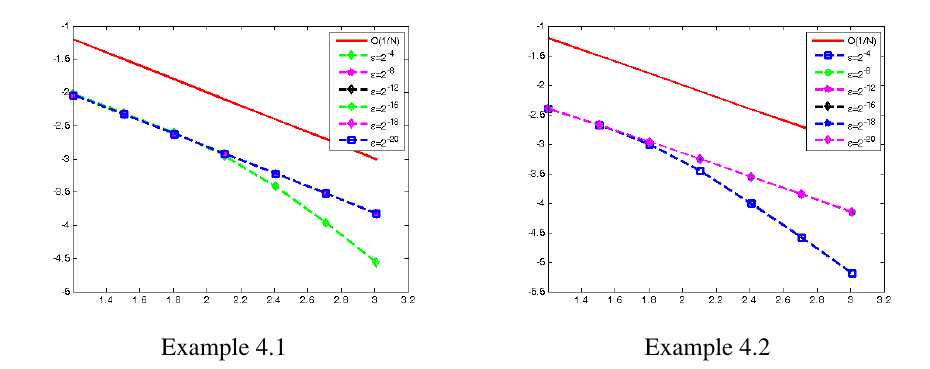
Figure 4. The Log-Log plot of the maximum absolute error for di ff erent values of ε .